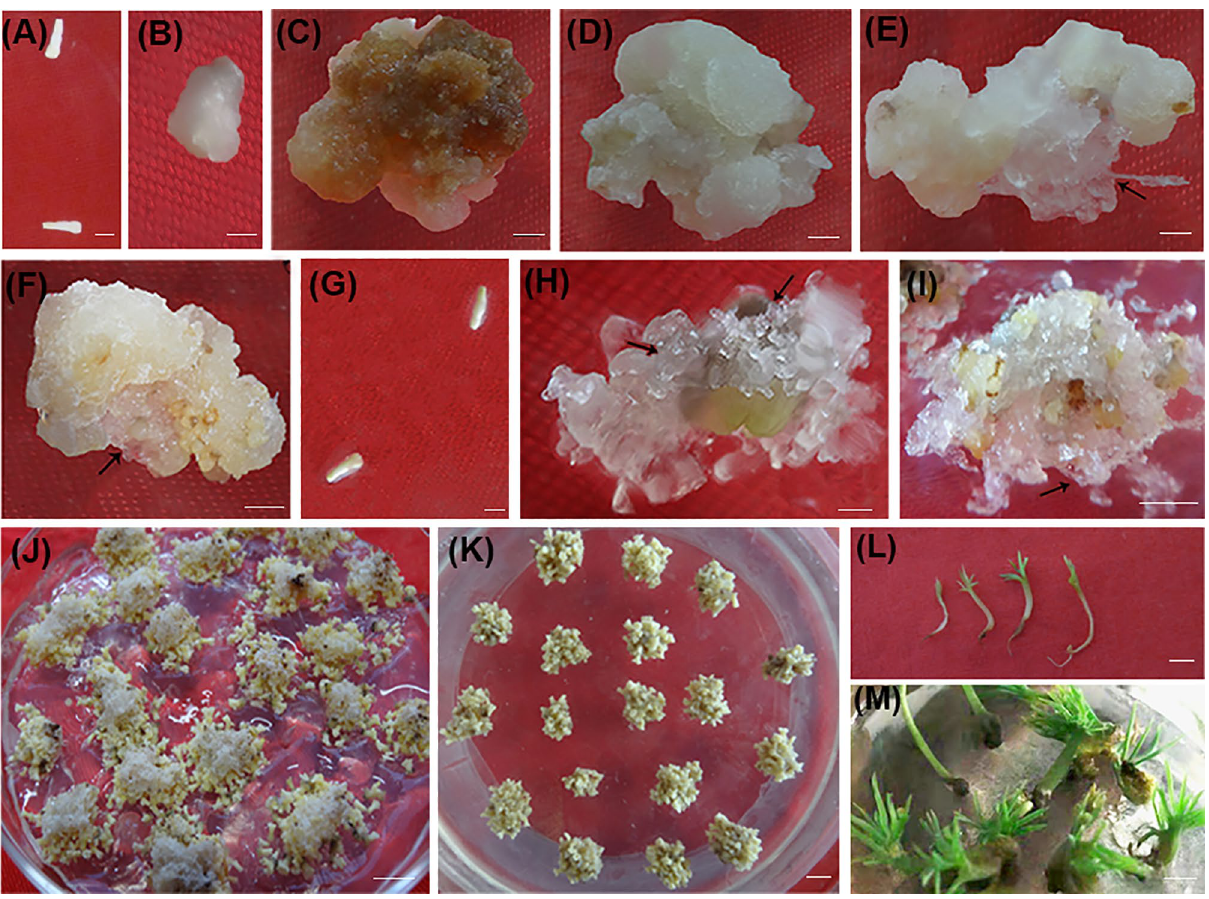
Figure 1. Somatic embryogenesis from zygotic embryos. ( A – F ) Induction of embryogenic tissues on zygotic embryos from mature seeds. Bars: 0.5 cm. ( A ) Cotyledonary zygotic embryos from mature seeds, ( B – E ) induction of calli on zygotic embryos from mature seed after 1 week ( B ), 4 weeks ( C – E ). ( C ) Non- embryogenic callus of browning with cells accumulating phenolic compounds. ( D ) Non-embryogenic callus without phenolics, ( E ) Embryogenic culture initiated on the calli mass. The arrow points to the filamentous and transparent embryogenic cultures. ( F ) proliferation of embryogenic culture with some pieces of non- embryogenic calli. ( G – I ) Induction of embryogenic tissues on zygotic embryos from immature seeds. Bars: 0.5 cm. ( G ) zygotic embryos from immature seeds. ( H ) Embryogenic culture initiated on immature zygotic embryos. ( I ) Proliferation of embryogenic cultures. ( J ) Differentiation of embryogenic tissues with maturation of somatic embryos on the proliferating ECs. ( K ) Maturation of somatic embryos on the maturation medium. ( L ) Germination. Bars: 0.5 cm. ( M ) Seedlings produced by germination from somatic embryos. Bars: 1